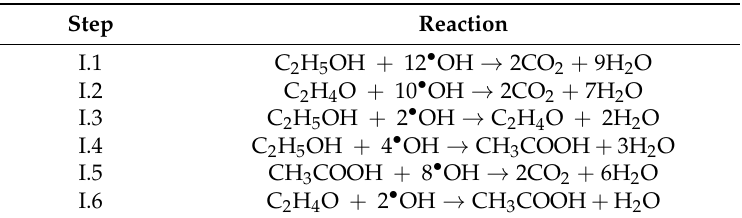
Table 4. Proposed oxidation reactions over TiO 2